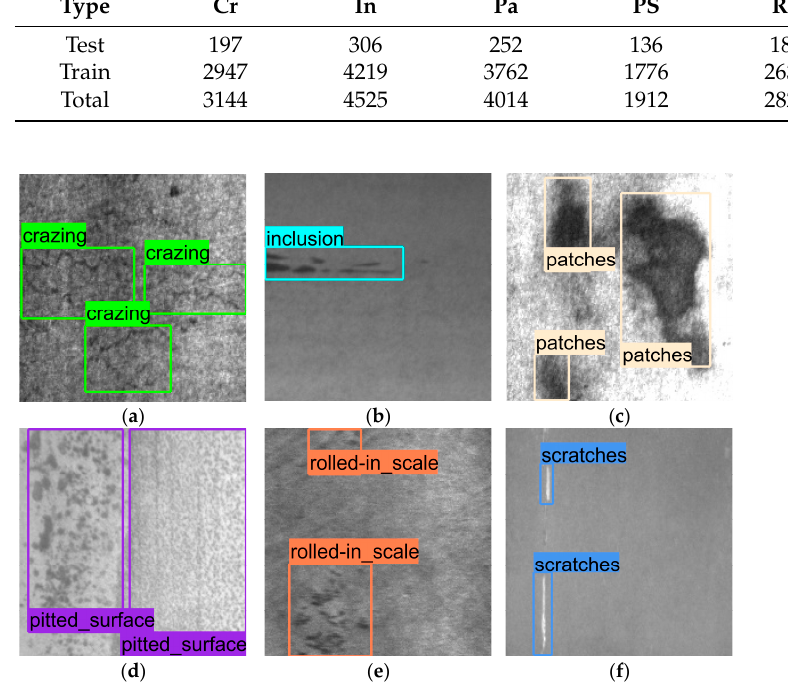
Figure 6. Examples of defective images with ground-truth annotations in the NEU-DET dataset: ( a ) Cr; ( b ) In; ( c ) Pa; ( d ) PS; ( e ) RS and ( f ) Sc. Table 1. Defect instance distribution of six defect types in train and test sets.